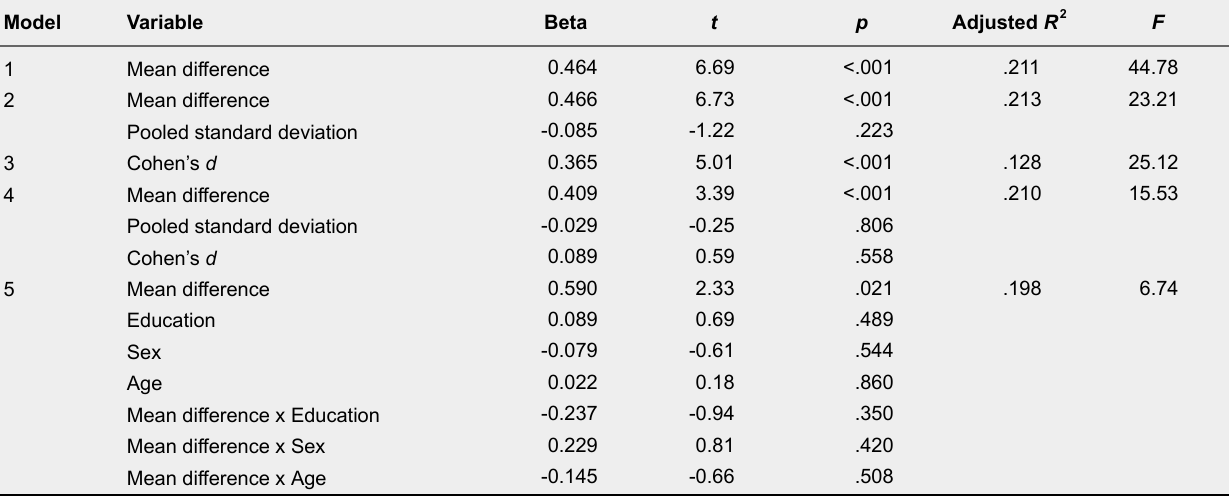
Results of the Multiple Regression Analyses on Individual Ratings in Experiment 1